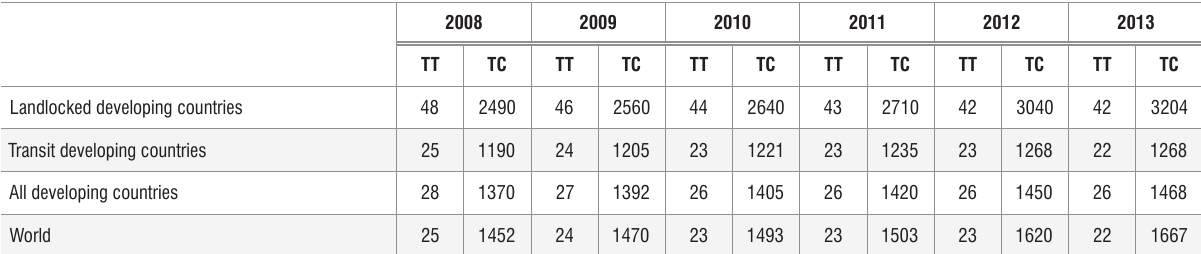
Landlocked developing countries Transit developing